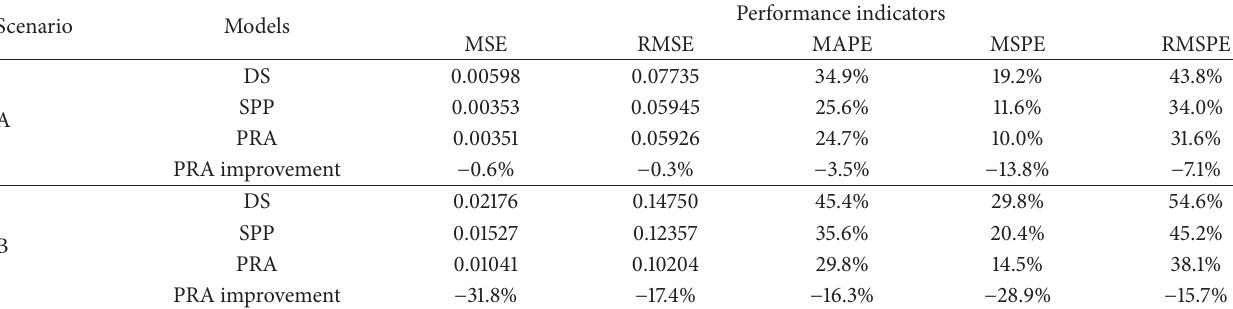
Table 3: Estimation accuracy of OD probe ratios.